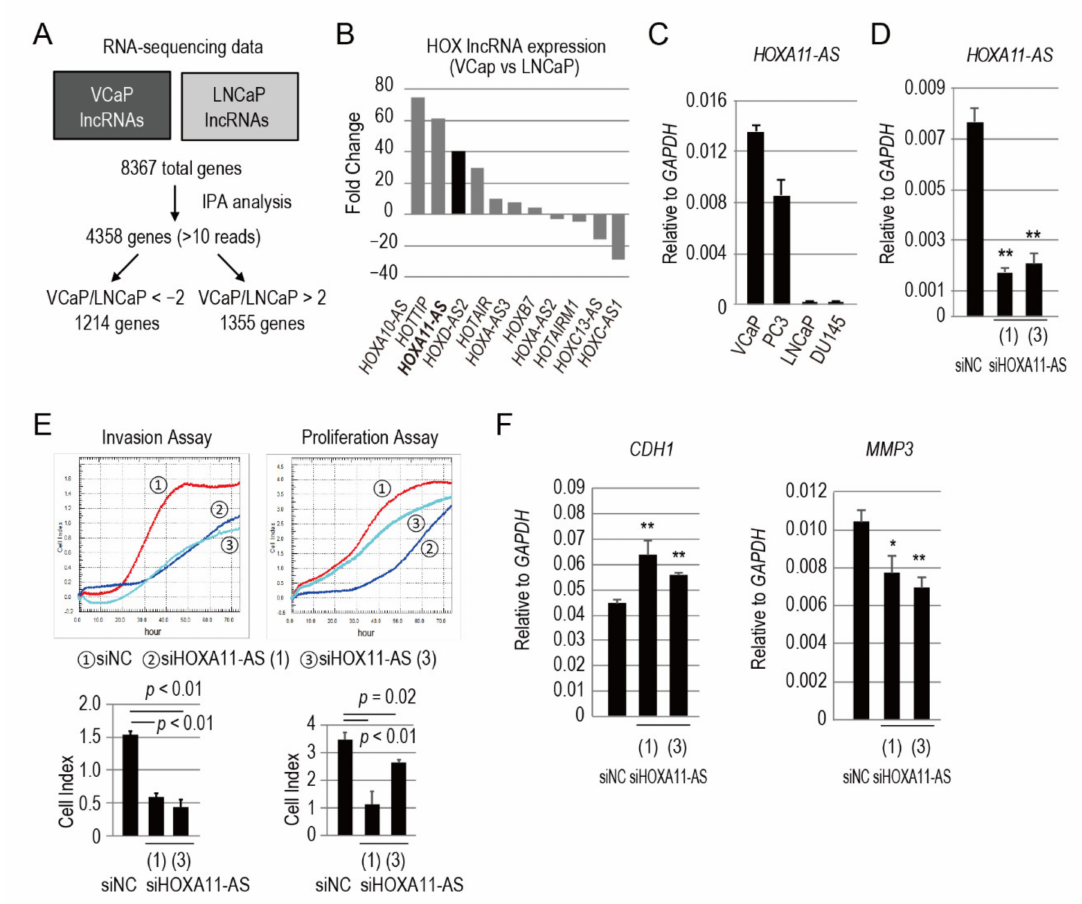
Figure 1. Identification of HOXA11-AS as a lncRNA highly expressed in bone metastasis-derived prostate cancer. ( A ) Flow diagram for the analysis of lncRNAs in VCaP and LNCaP cell lines. Sequencing data were downloaded from NCBI Gene Expression Omnibus (GSE82225). ( B ) Expression analysis of HOX cluster-derived lncRNAs in VCaP and LNCaP cell lines. Y-axis shows the fold change of the number of reads per kilobase of exon model per million mapped reads (RPKM) in VCaP cells with respect to the RPKM in LNCaP cells, calculated as the ratio between RPKM (VCaP)/RPKM(LNCaP) for each lncRNA shown in the X-axis. ( C ) HOXA11-AS expression analysis by qPCR in four different prostate cancer cell lines. ( D ) HOXA11-AS knockdown efficiency assessed by qPCR in PC3 cells transfected with siRNAs targeting HOXA11-AS . ( E ) xCELLigence real-time invasion assay of PC3 cells transfected with siRNA targeting HOXA11-AS ; cell index represents invading cells at 48 h (left panel). xCELLigence real-time proliferation assay of PC3 cells transfected with siRNA targeting HOXA11-AS ; cell index represents proliferating cells at 48 h (right panel). ( F ) CDH1 and MMP3 expression analysis by qPCR in PC3 cells transfected with siRNAs targeting HOXA11-AS . qPCR analyses were performed in triplicate ( n = 3). Expression levels are presented relative to values of GAPDH , used as a reference gene. Values represent mean ± standard deviation. Statistical significance was determined by unpaired t -tests. *, p < 0.05. **, p <